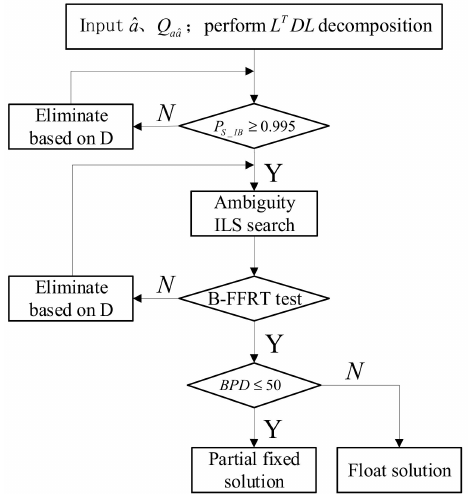
Figure 5. Flow chart of Triple Checked Partial Ambiguity Resolution